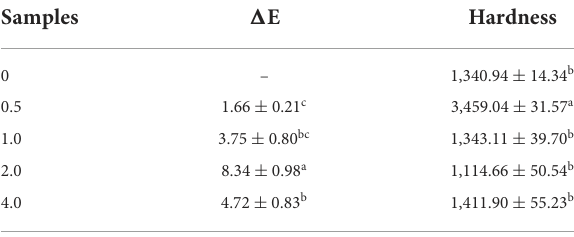
TABLE 1 Color properties and texture properties of biscuit with different concentrations (0, 0.1, 0.25, and 0.5 mg/mL) of LSOPC. Samples 1 E